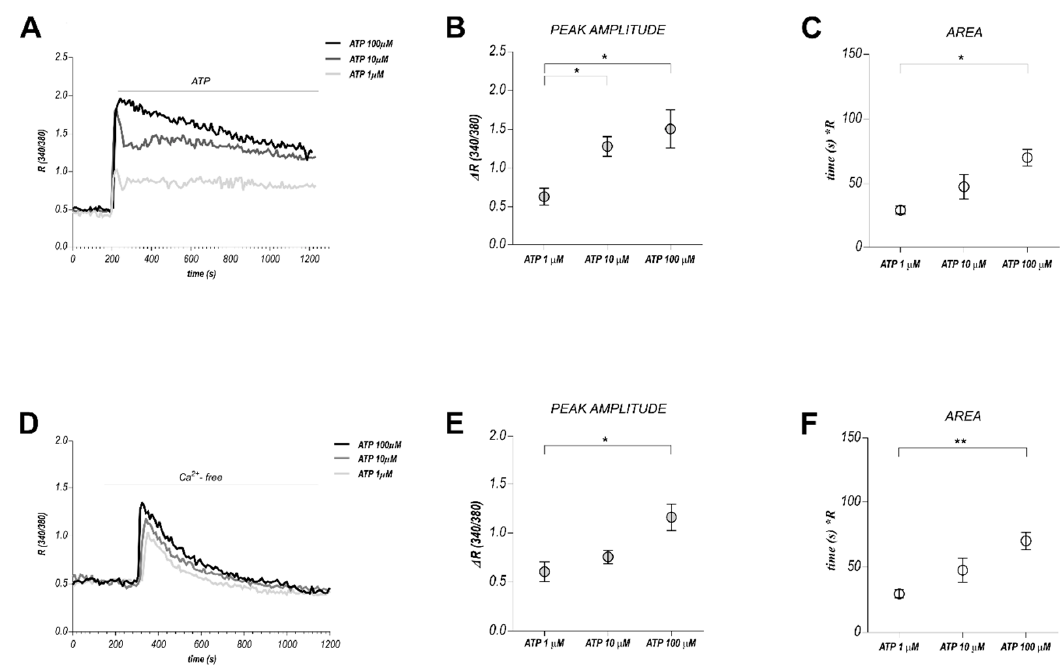
Figure 1. High eATP stimulation triggers biphasic Ca 2 + signals in BTEC. ( A ) Representative traces of di ff erent Ca 2 + signals evoked by three di ff erent eATP concentrations (1, 10, 100 µ M). ( B , C ) Quantification of the peak amplitude and area obtained upon 1, 10, 100 µ M ATP stimulation. Area is calculated at 300 s from the beginning of the response. Data are expressed as mean ± SEM. * p -value < 0.05. ( D ) Representative traces obtained upon 100 µ M ATP stimulation in Ca 2 + free extracellular medium. ( E , F ) Quantification of peak amplitude and total area under the calcium spike. Data are expressed as mean ± SEM. * p -value < 0.05; ** p -value < 0.005. Traces in A and D represent the average of all the cells in one representative experiment.